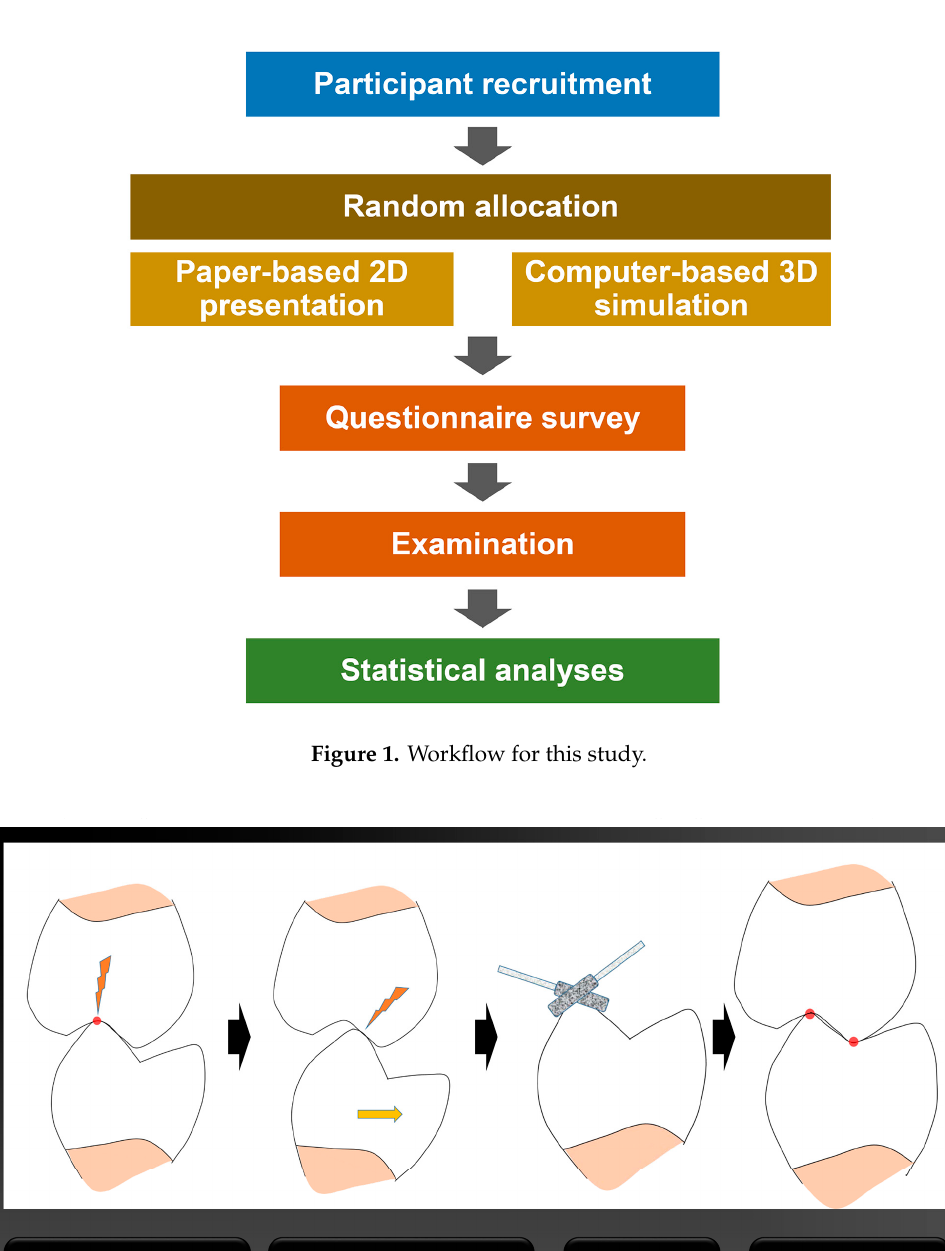
Figure 1. Workflow for this study.